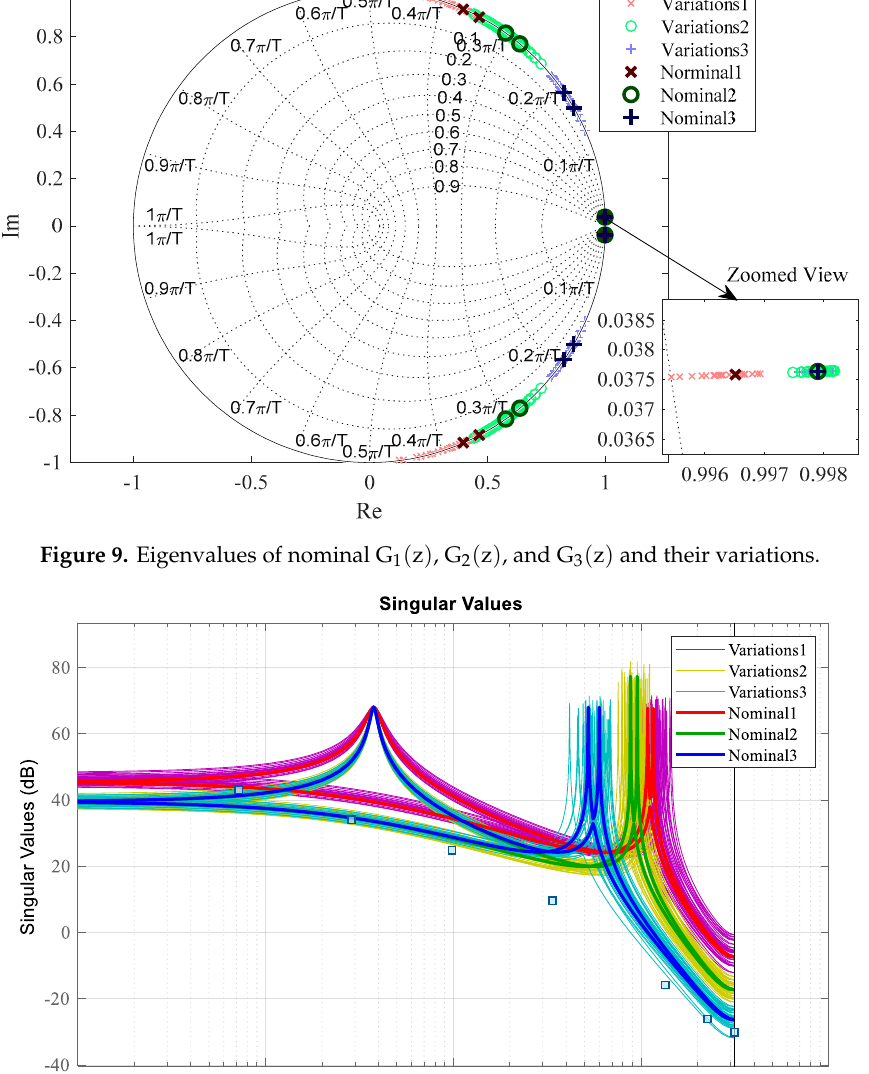
Figure 10. Singular values diagram for G 1 (z), G 2 (z), and G 3 (z) and their variations.